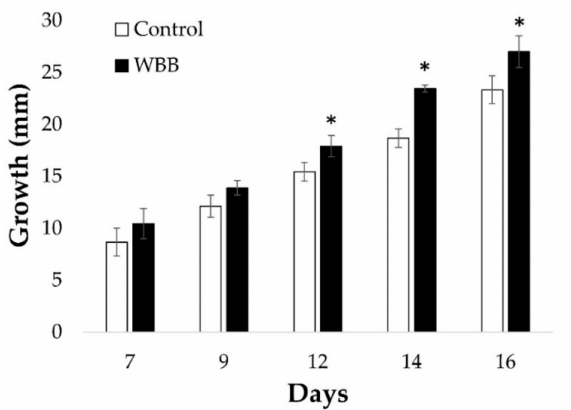
Figure 2. Inonotus obliquus cell culture growth in presence of white birch bark. I. obliquus was grown on a solid medium pH 6.2 at 28 ◦ C for 16 days on agar plates containing a yeast malt agar (Control) medium (white bars) or YMA supplemented with white birch bark (WBB) fragments (black bars). The measurements of the diameter (mm) of growth were taken every two days starting at day seven. Results show the average ( ± error bars) growth of three biological repetitions per condition. Statistical significance is annotated with an asterix (*) according to ANOVA test results with p < 0.05.